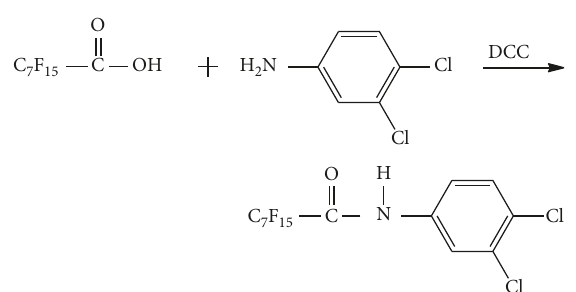
Figure 1: Derivatization reaction of PFOA with DCA by the DCC